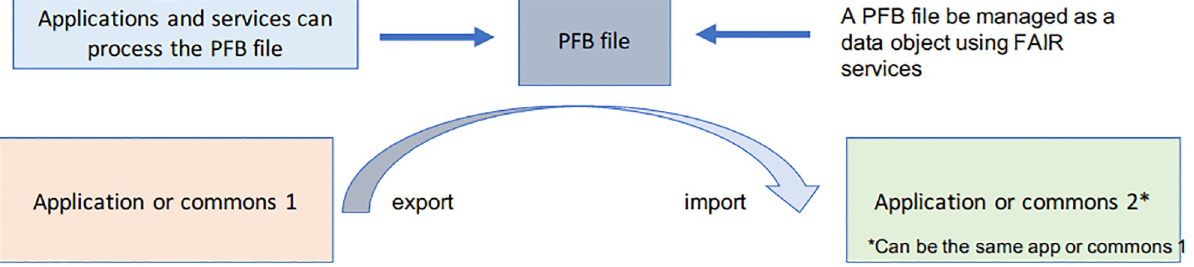
Fig 1. A data commons or application in a data ecosystem can export a PFB file and the same or another data commons or application can import it.